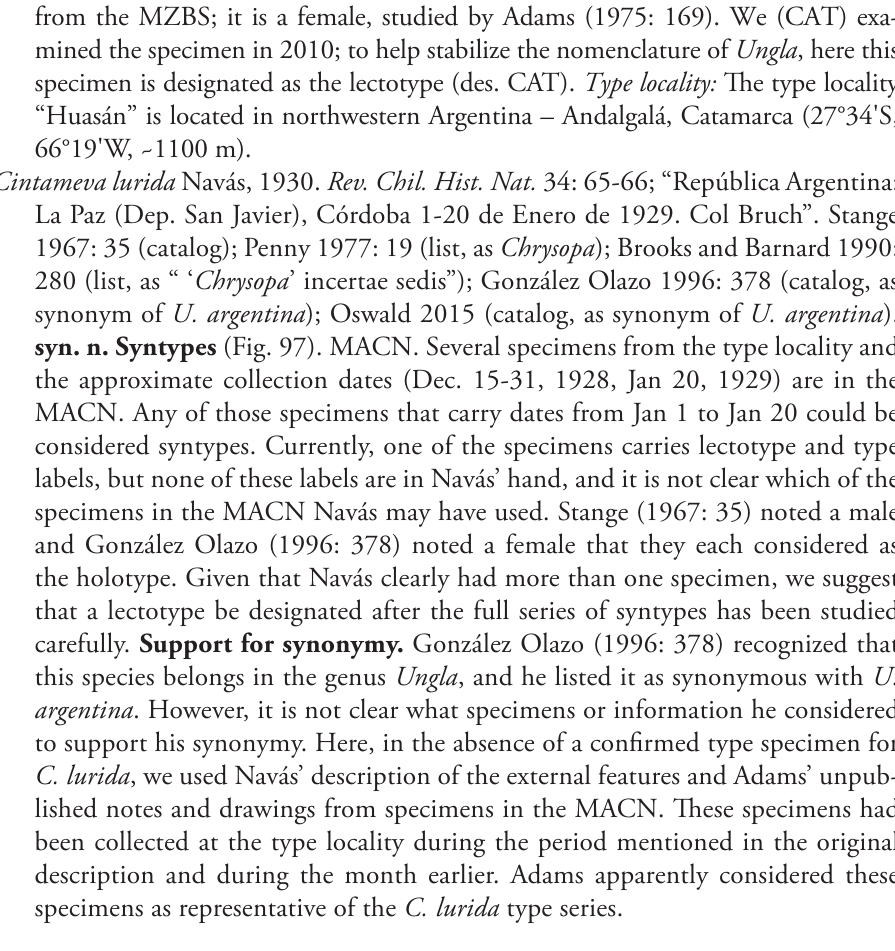
(Figs 95, 96): MZBS, female (examined). Monserrat (1985: 240) reported a type from the MZBS; it is a female, studied by Adams (1975: 169). We (CAT) exa- mined the specimen in 2010; to help stabilize the nomenclature of Ungla , here this specimen is designated as the lectotype (des. CAT). Type locality: The type locality “Huasán” is located in northwestern Argentina – Andalgalá, Catamarca (27°34'S, 66°19'W, ~1100